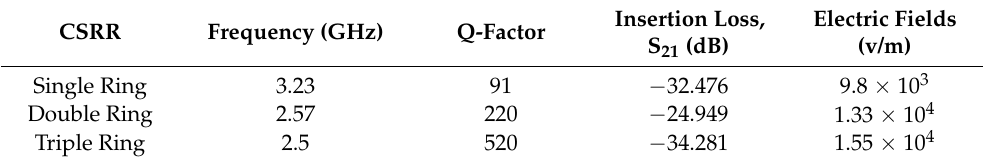
Table 3. The comparison of simulation performance of different rings of CSRR.